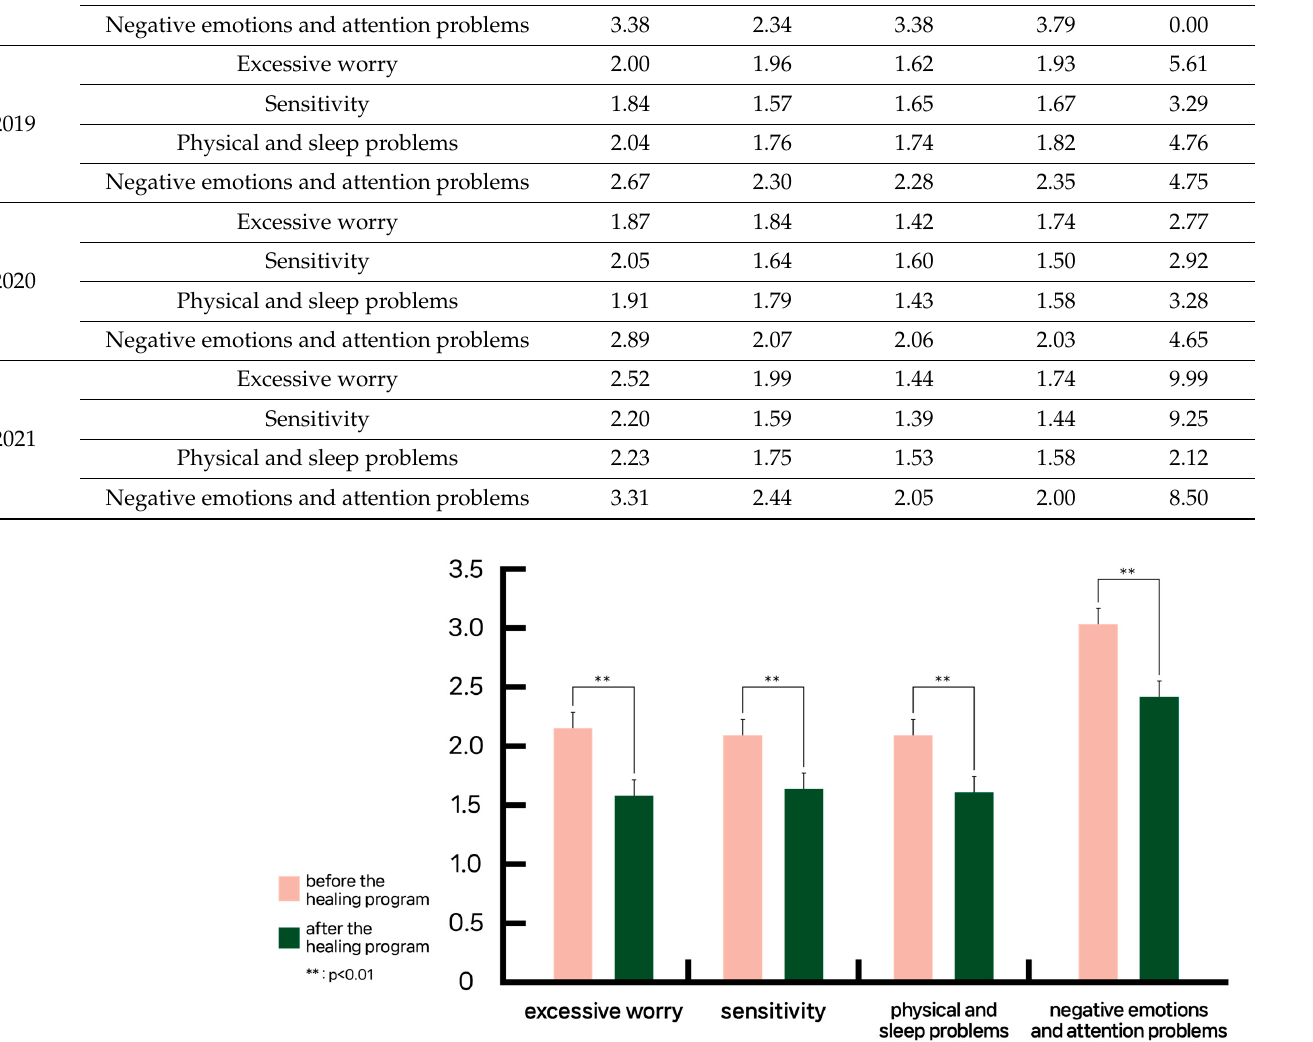
Figure 3. Results of subdomains for RCMAS during 2018–2021.